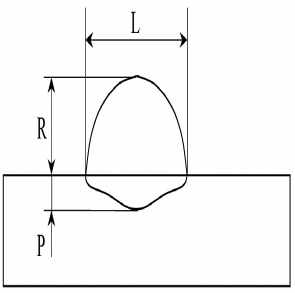
Figure 3. Geometrical parameters measured in the weld